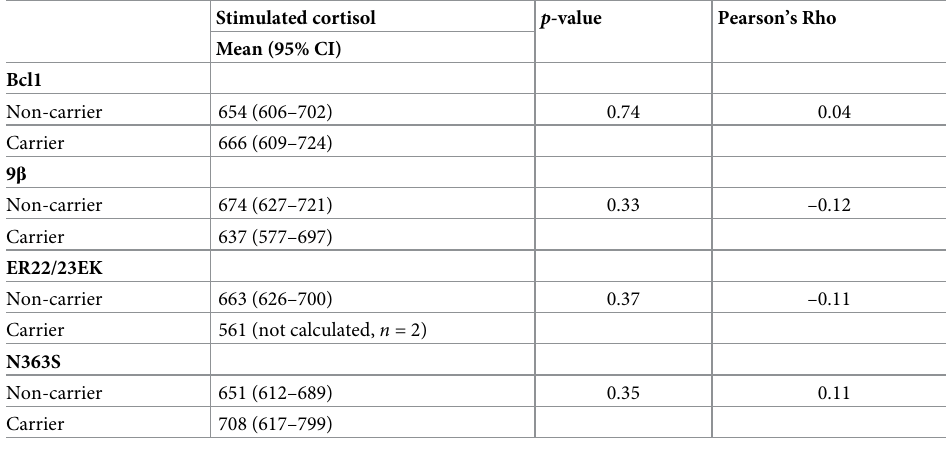
Table 4. Differences in stimulated plasma-cortisol for non-carriers vs. carriers of each polymorphism.